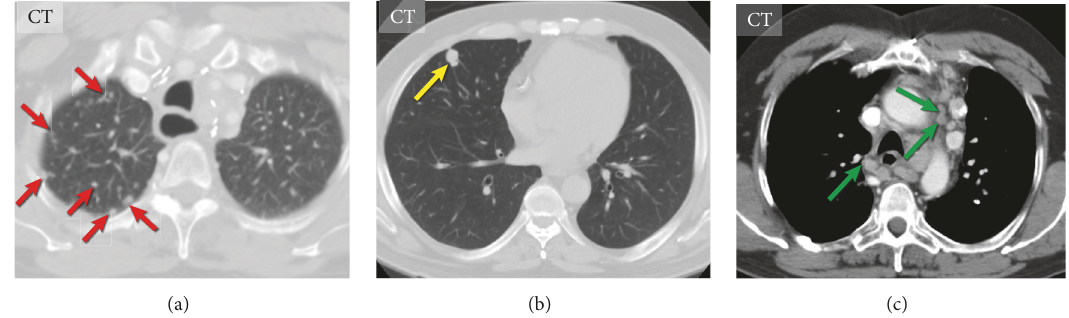
Figure 8: Computed tomography of the chest of different patients with metastatic medullary thyroid carcinoma. Disseminated pulmonary metastases (red arrows) (a). Solitary pulmonary metastases (yellow arrow) (b). Extensive metastatic mediastinal lymphadenopathy (green arrows)